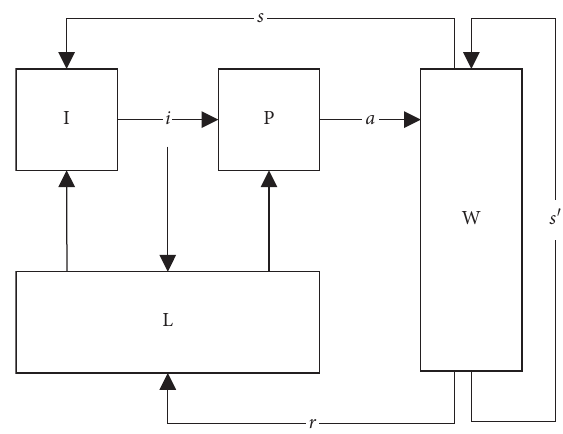
Figure 1: Framework of reinforcement